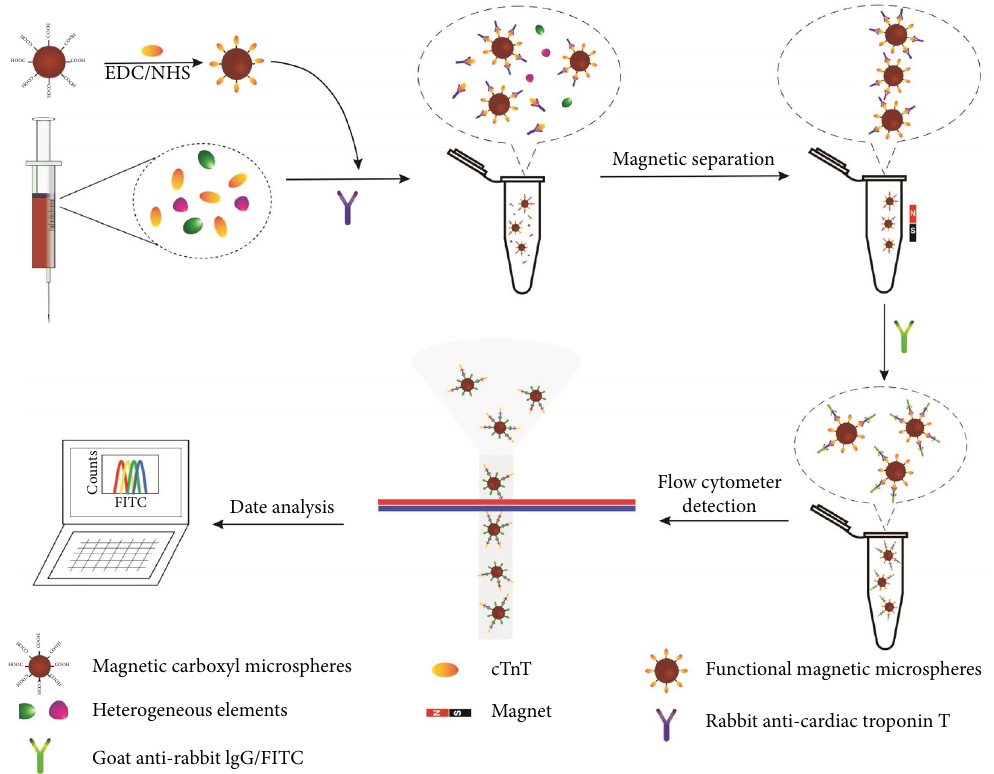
Figure 1: Schematic representation of a cTnT detection method based on magnetic